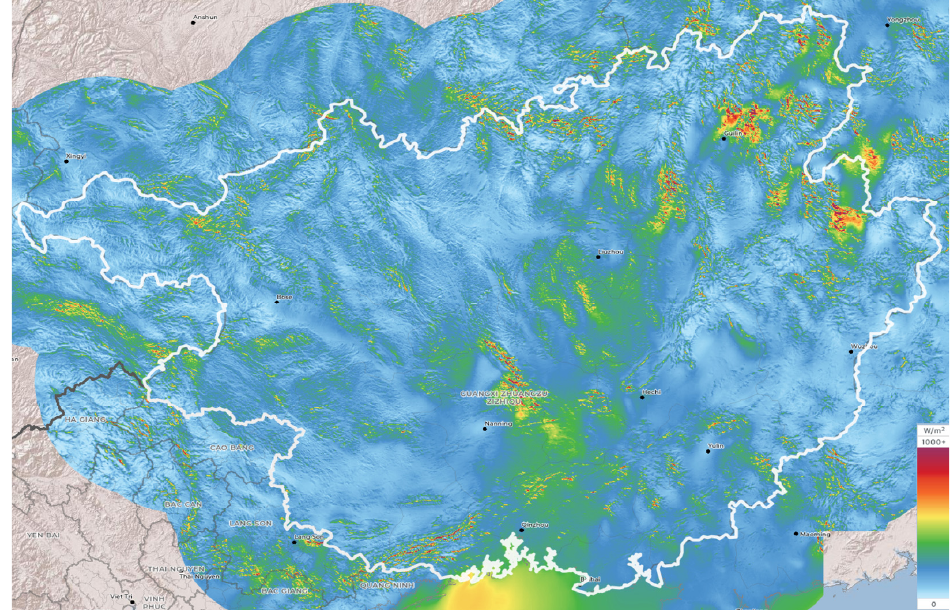
Figure 3. Guangxi distribution of the mean wind power density at 100 m [ 59 ] .